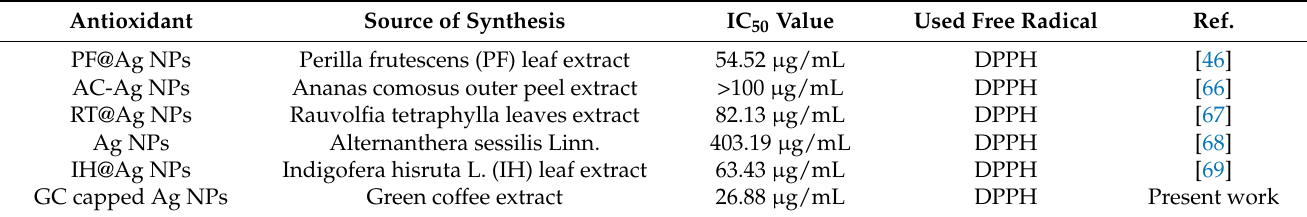
Figure 11. The antioxidant activity of GC-capped Ag NPs using different concentrations to determine the IC 50 after linear fitting for experimental data. Table 2. Comparison between different biogenic silver-based nano-antioxidants and our GC-capped Ag NPs regarding the reaction and performance